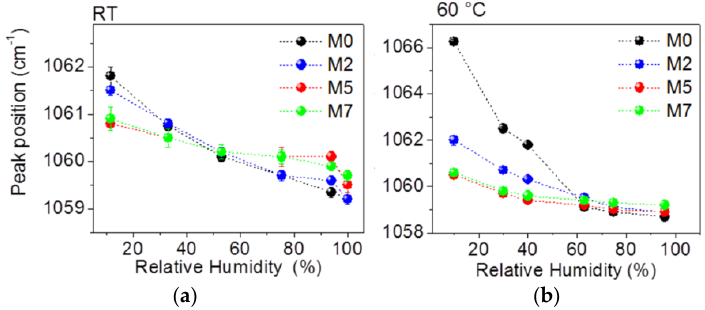
Figure 5. Peak position attributed to the SO 3− vibration mode measured on the pure Nafion™ and on composite membranes in function of RH ( a ) at room temperature; and ( b ) at 60 °C.